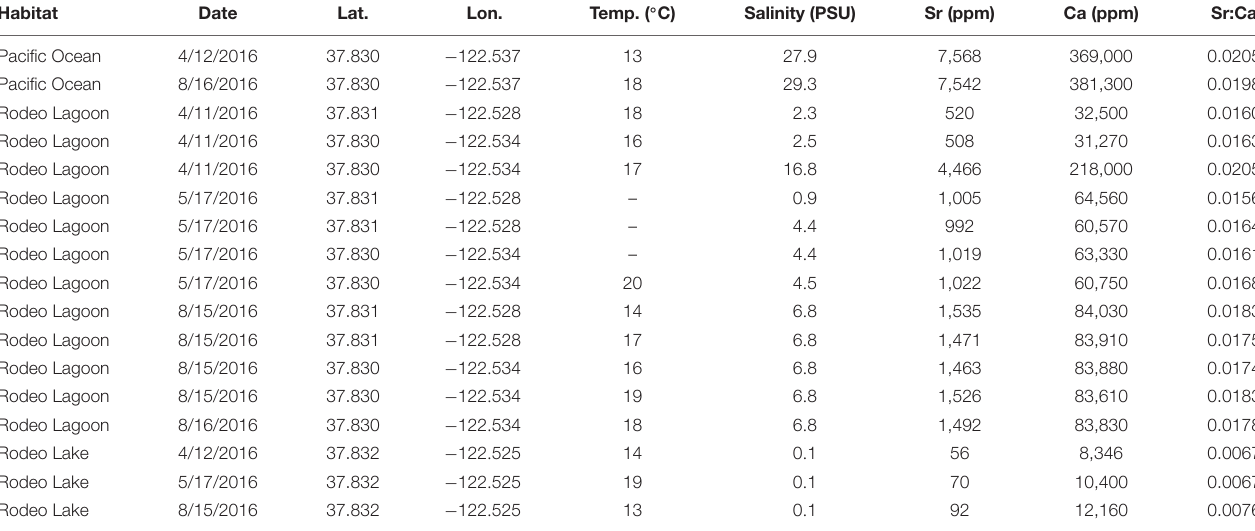
TABLE 2 | Sources and details of water samples examined in this study. Habitat